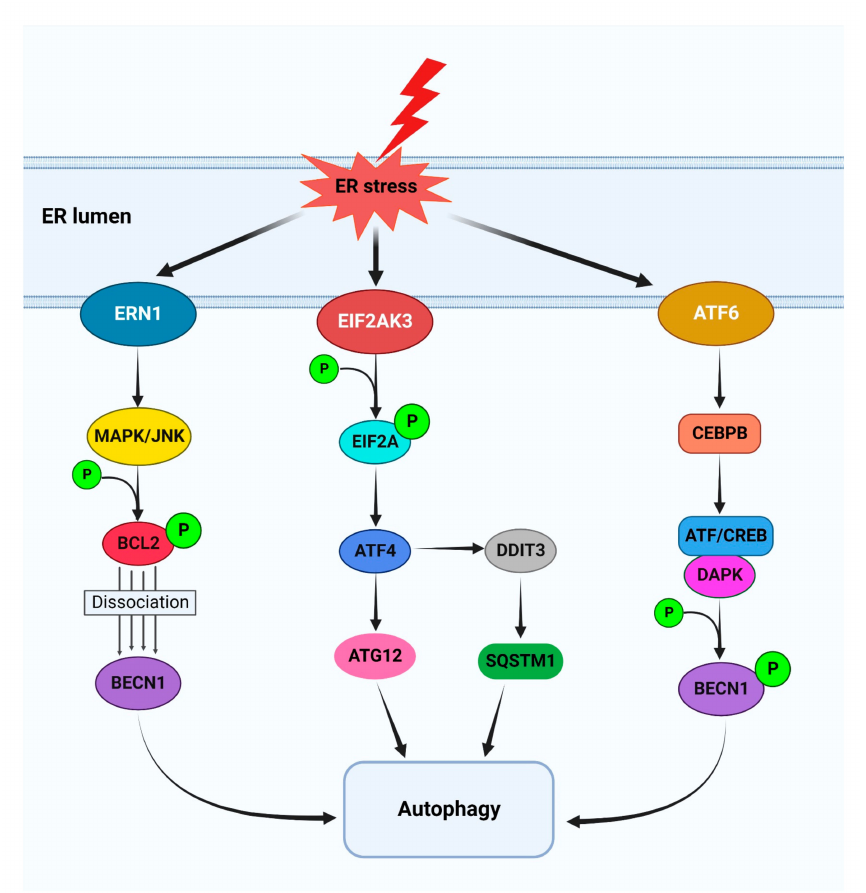
Figure 4. The interplay between ER stress (UPR) and autophagy. UPR signaling pathways and ER stress activate autophagy. The ERN1 arm of the ER stress response causes MAPK/JNK